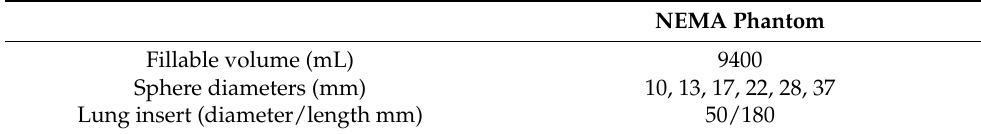
Figure 1. NEMA image-quality phantom with a lung insert, and spherical lesions of known dimensions. Table 1. NEMA IQ Phantom characteristics.